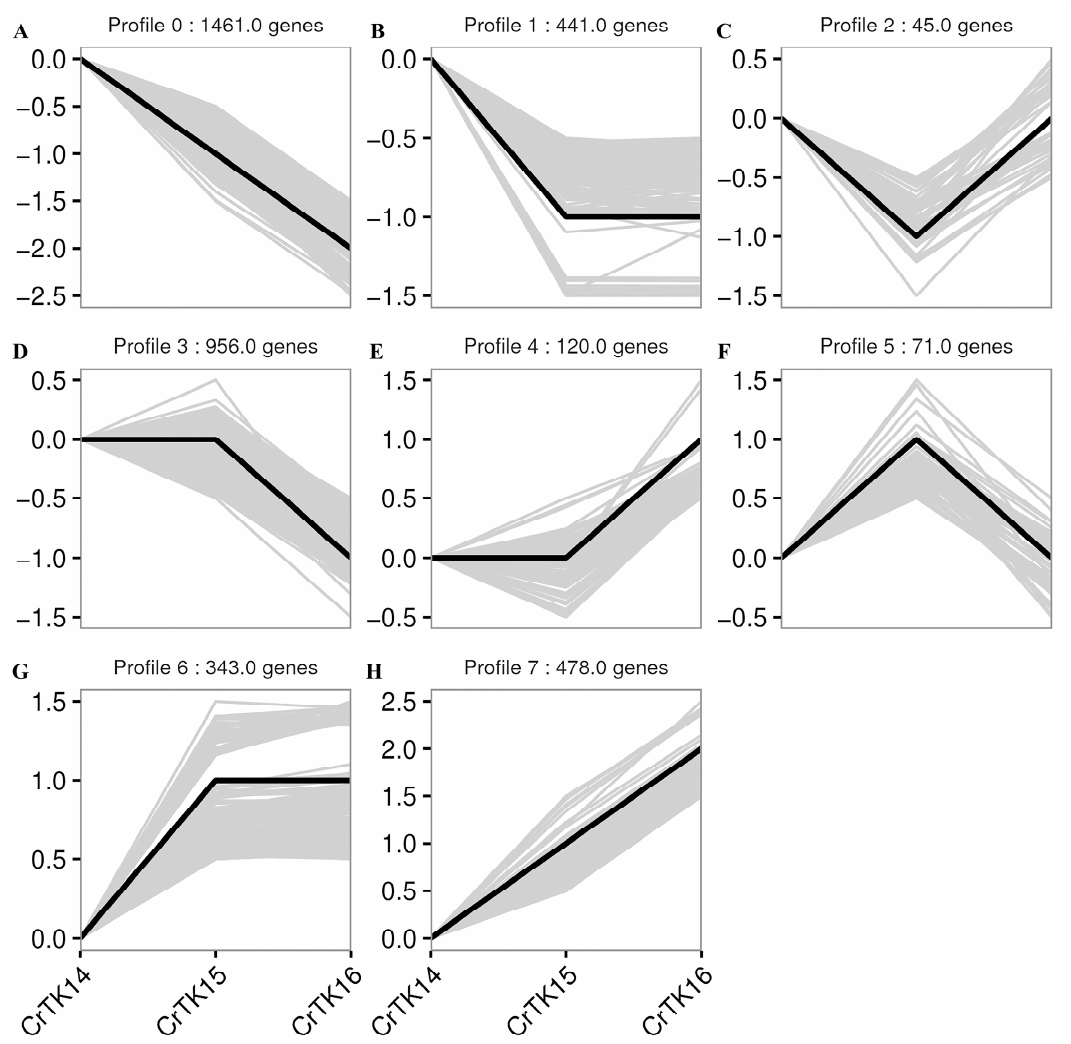
Figure 6. Gene expression profiles of the DEGs. ( A – H ) The gene expression Profile 1 to Profile 7 during three stages. The gene data were normalized according to the trend. The ordinate represents the gene expression value. The black curve lines represent the trends, and the gray lines represent each gene in the